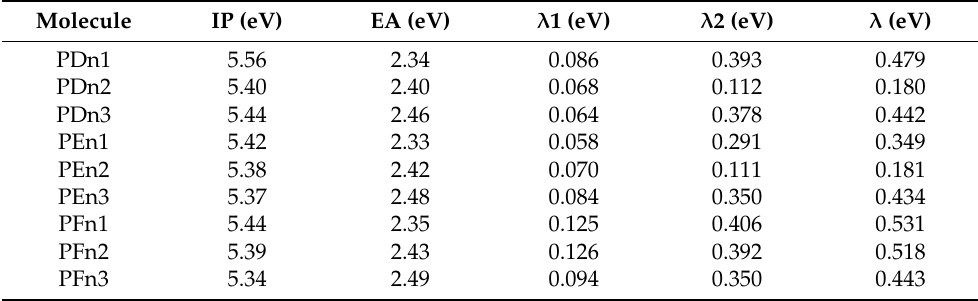
Figure S3: The optimized geometry at ground state and HOMO and LUMO orbital electron cloud distribution of the